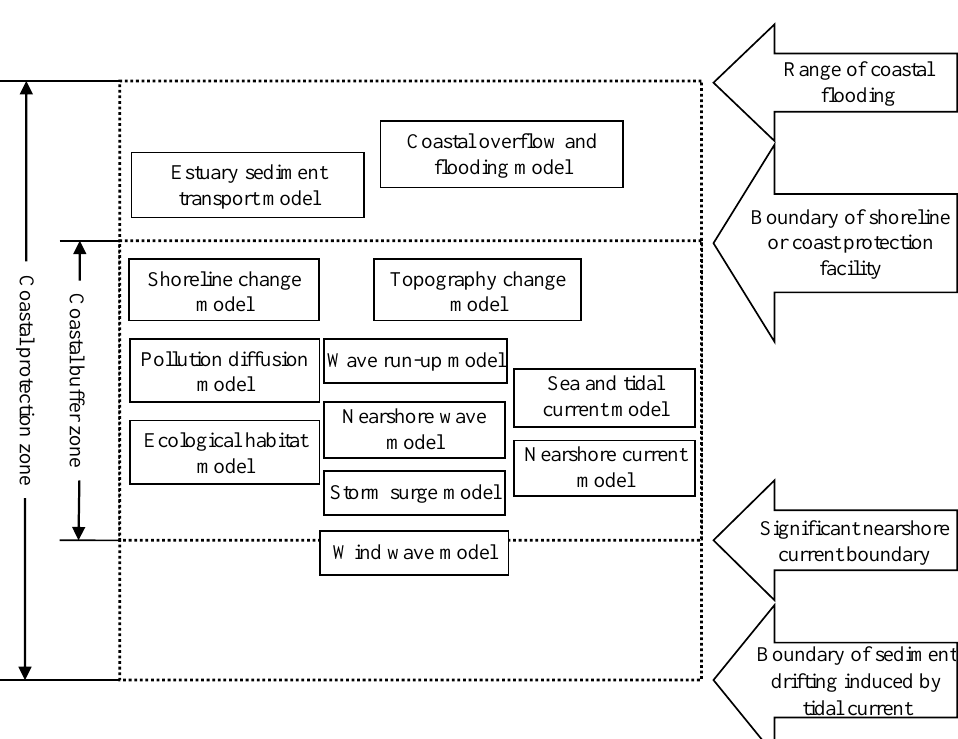
Figure 6. Schematic diagram of research on the application of numerical models to identify the impact factors of coastal buffer zones.